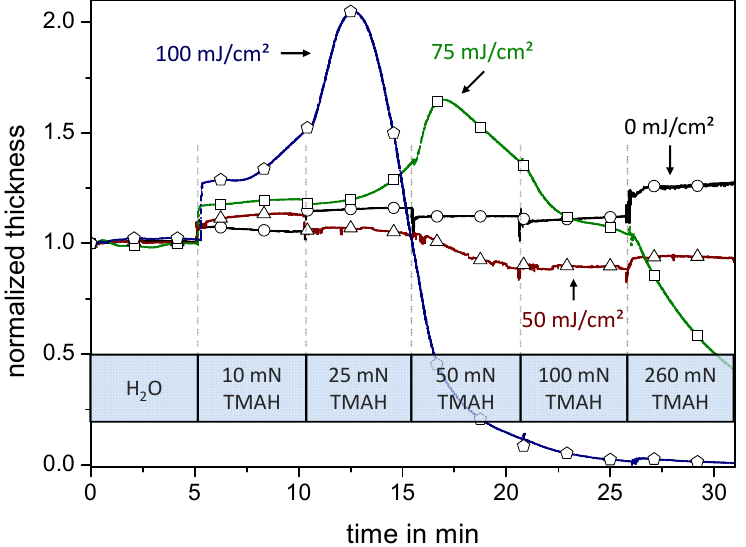
Figure 6. Quartz crystal microbalance (QCM) measurements of four resist films exposed to different UV exposure doses are shown. The graphs show the corresponding QCM frequencies change—translated to normalized film thickness change [26]—during the periodic titration of a concentrated developer solution observable due to the transient oscillation. The unexposed hydrophobic resist film ( ○ ) stays at a nearly constant film thickness while slight swelling and dissolving of reacted resist material is observable for the resist film exposed to 50 mJ/cm² (  ). The resist film exposed to 75 mJ/cm² ( □ ) shows a more distinct swelling character. The swelling slightly begins at the first titration and increases markedly until the concentration of 50 mN where the dissolving character exceeds. This behavior of swelling and dissolving is also observed for the resist exposed to 100 mJ/cm² ( ⌂ ) but the dissolution shifts to a lower concentration of 25 mN. The exposed resist film is fully developed at a concentration of 100 mN